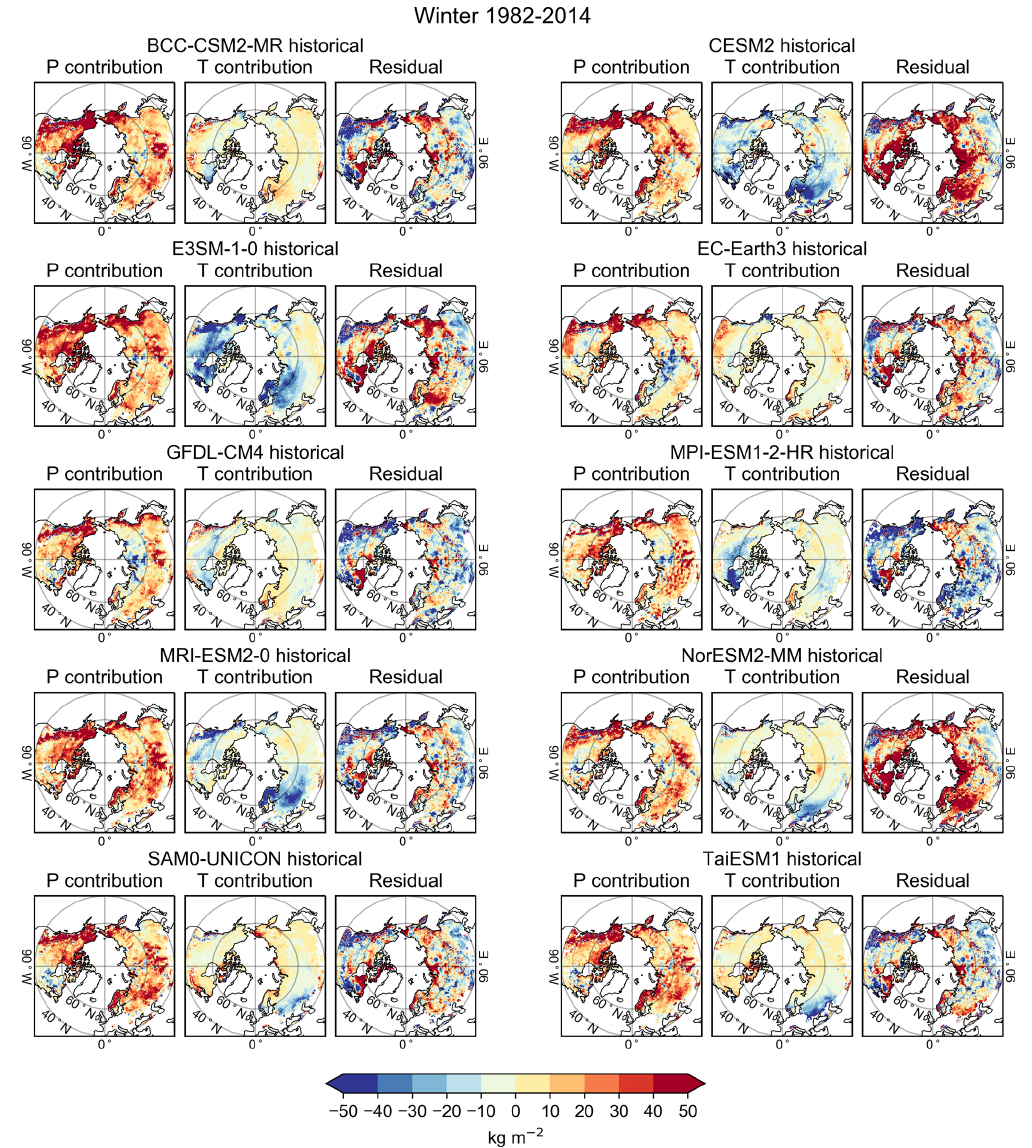
Figure 7. Spatial distribution of the P contribution, the T contribution, and the residual for each model in winter